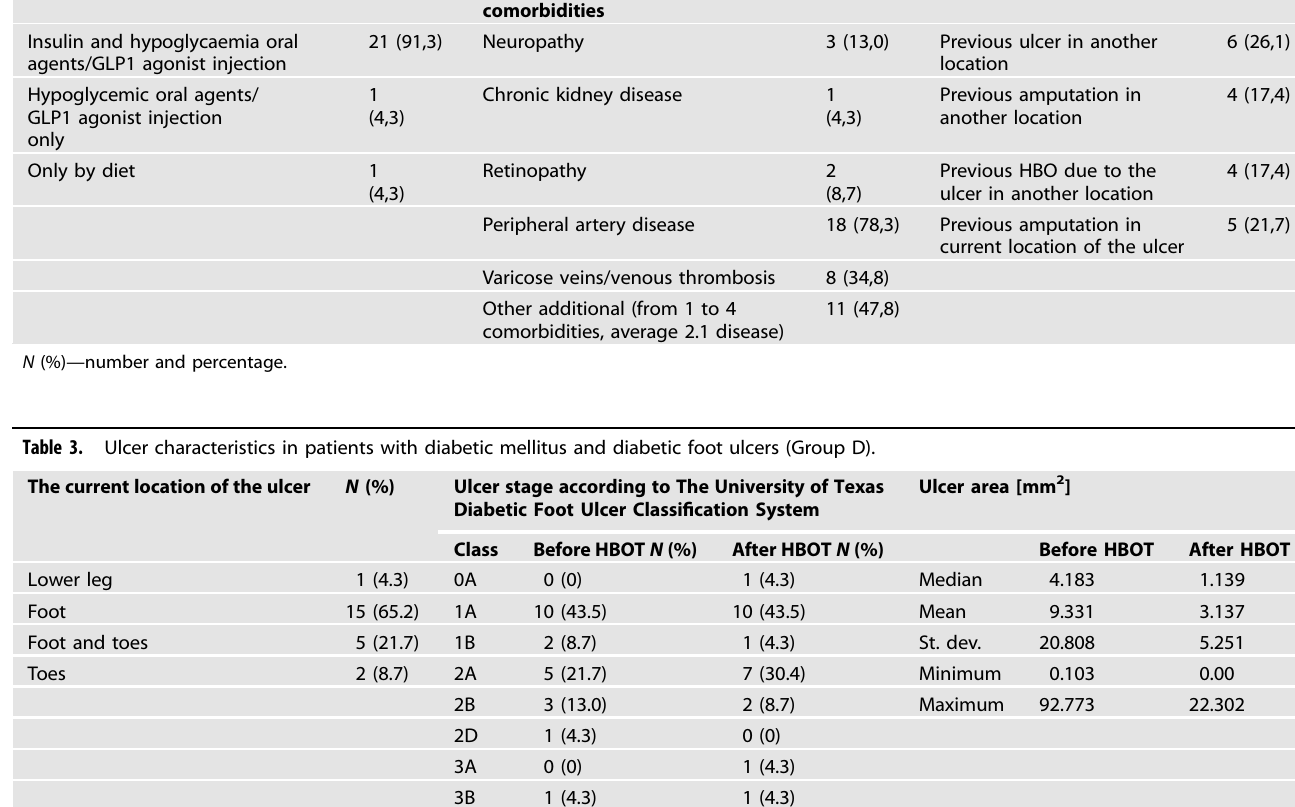
6 (26,1) 4 (17,4) 4 (17,4) 5 (21,7)